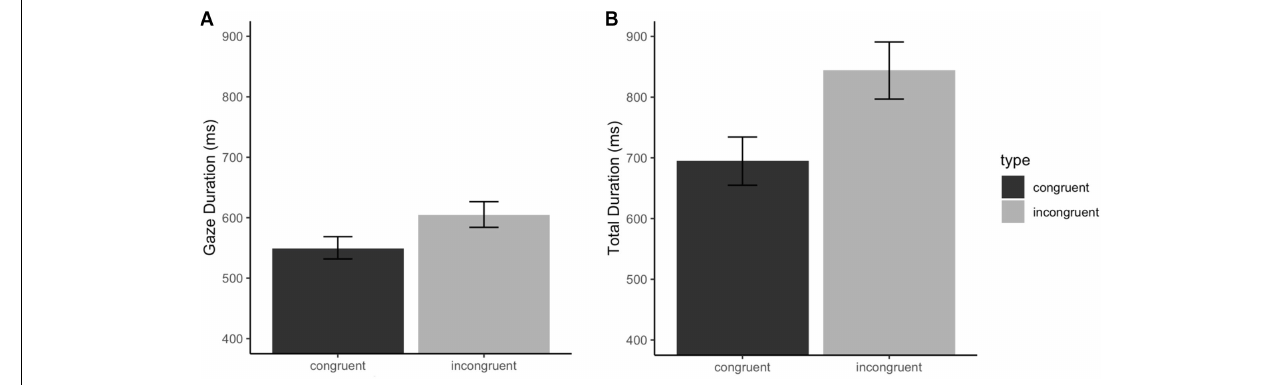
Frontiers in Psychology |